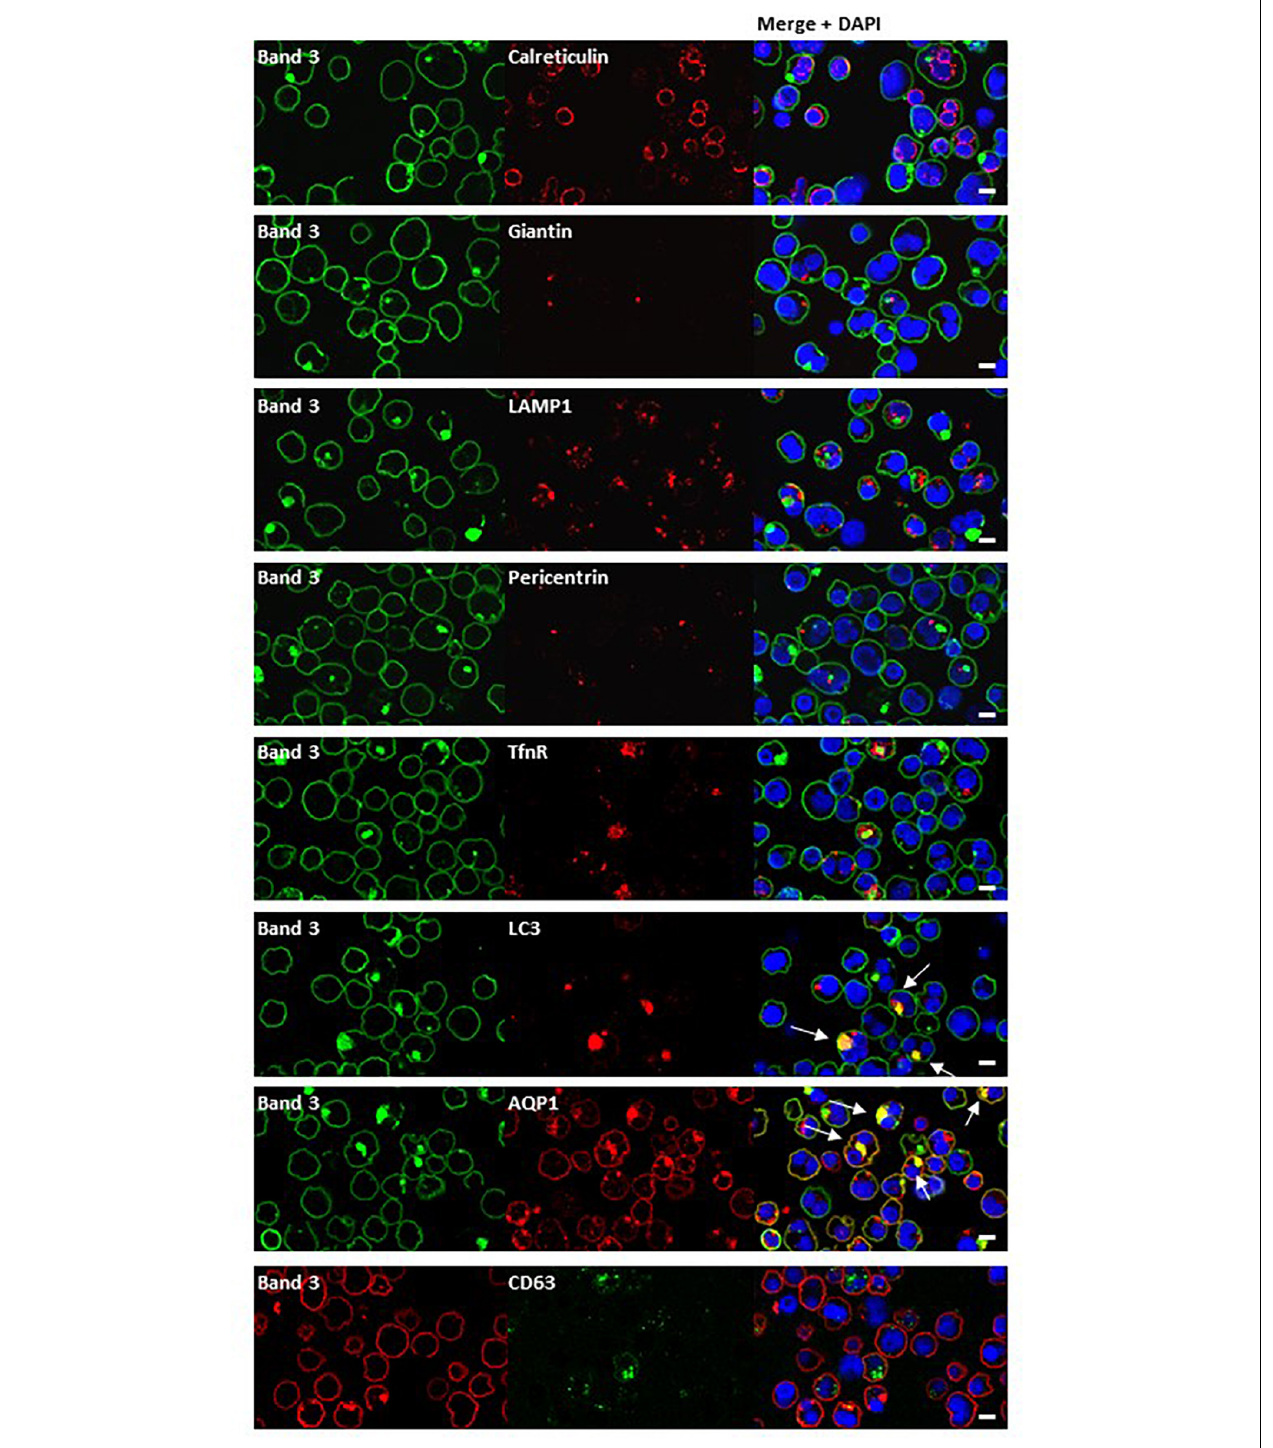
FIGURE 7 | Immunocytochemistry of homozygous SAO erythroblasts. Late stage homozygous SAO cells were dual stained using antibodies against band 3 (BRIC170, green; or BRAC17, red) and markers for plasma membrane, internal compartments or organelles. Markers used were: Calreticulin (endoplasmic reticulum; ab2907), Giantin [Golgi; PRB-114C (Covance)], LAMP1 (lysosome associated membrane protein 1; lysosome; ab24170), Pericentrin (microtubule organizing center; ab4448), TfnR (Transferrin receptor/CD71; ab84036), LC3 [microtubule-associated proteins 1A/1B light chain 3A; autophagosome; PM036 (MBL)], AQP1 (Aquaporin-1; plasma membrane), and CD63 [recycling endosome; 556019 (BD Biosciences)]. Colocalization is indicated with white arrows (yellow areas in merged images). Images are representative of at least 5 different fields from one experiment. Scale bars represent 5 µ m.